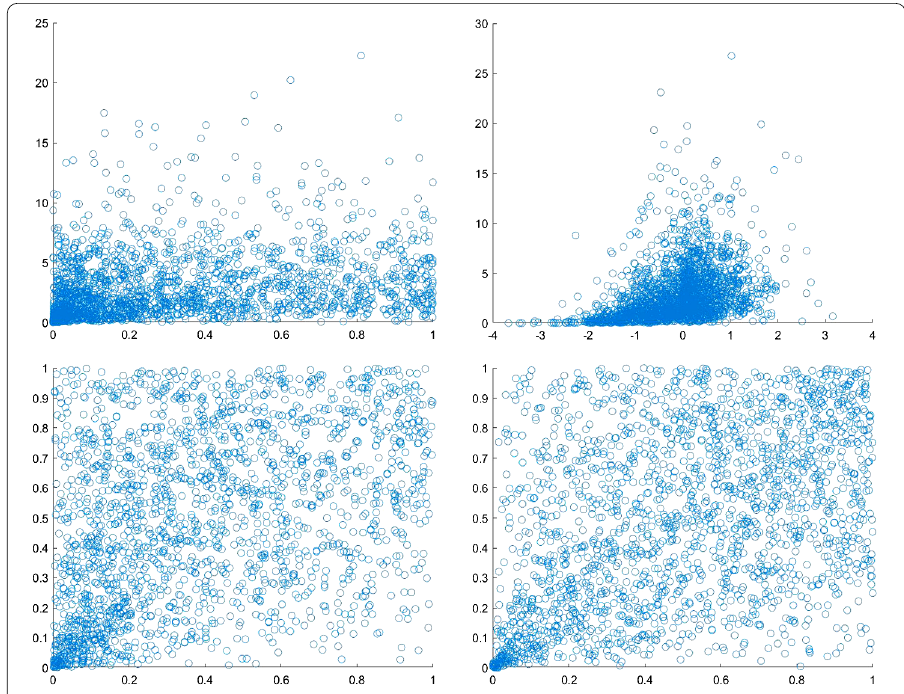
Figure 2 Scatter and rank-rank plots for a sample of size 2000 from the Clayton copula based on censored data with τ = 1/2, once the margins have been transformed to F 1 and F 2 . ( a , top left): F 1 = B (0.5,0.7) and F 2 = ε (3); ( b , top right): F 1 = N (0,1) and F 2 = ε (3); ( c , bottom left): F 1 = F 2 = U (0,1); ( d , bottom right): the rank-rank plot for Clayton